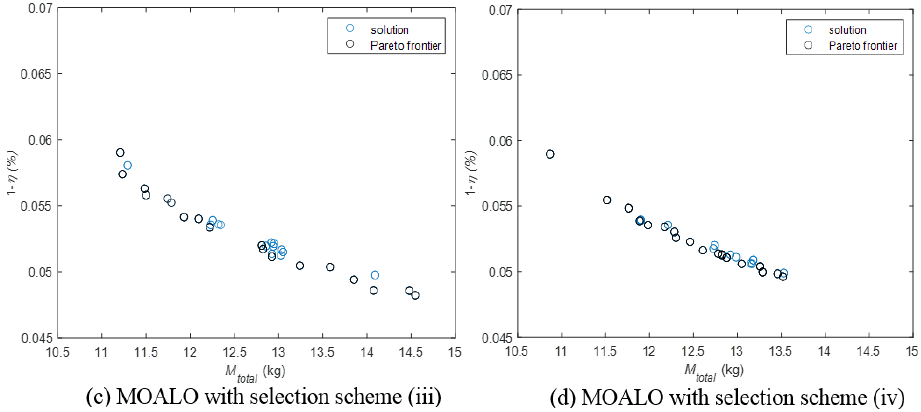
Figure 2. Pareto set points (filtered of 30 runs) using MOALO approaches.